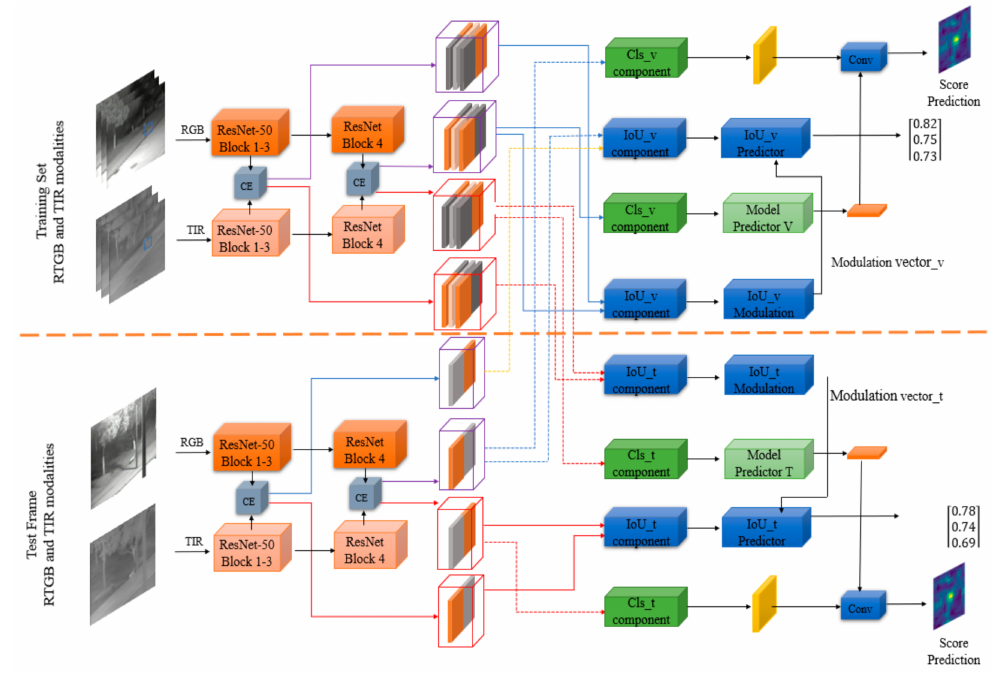
Figure 5. The framework of